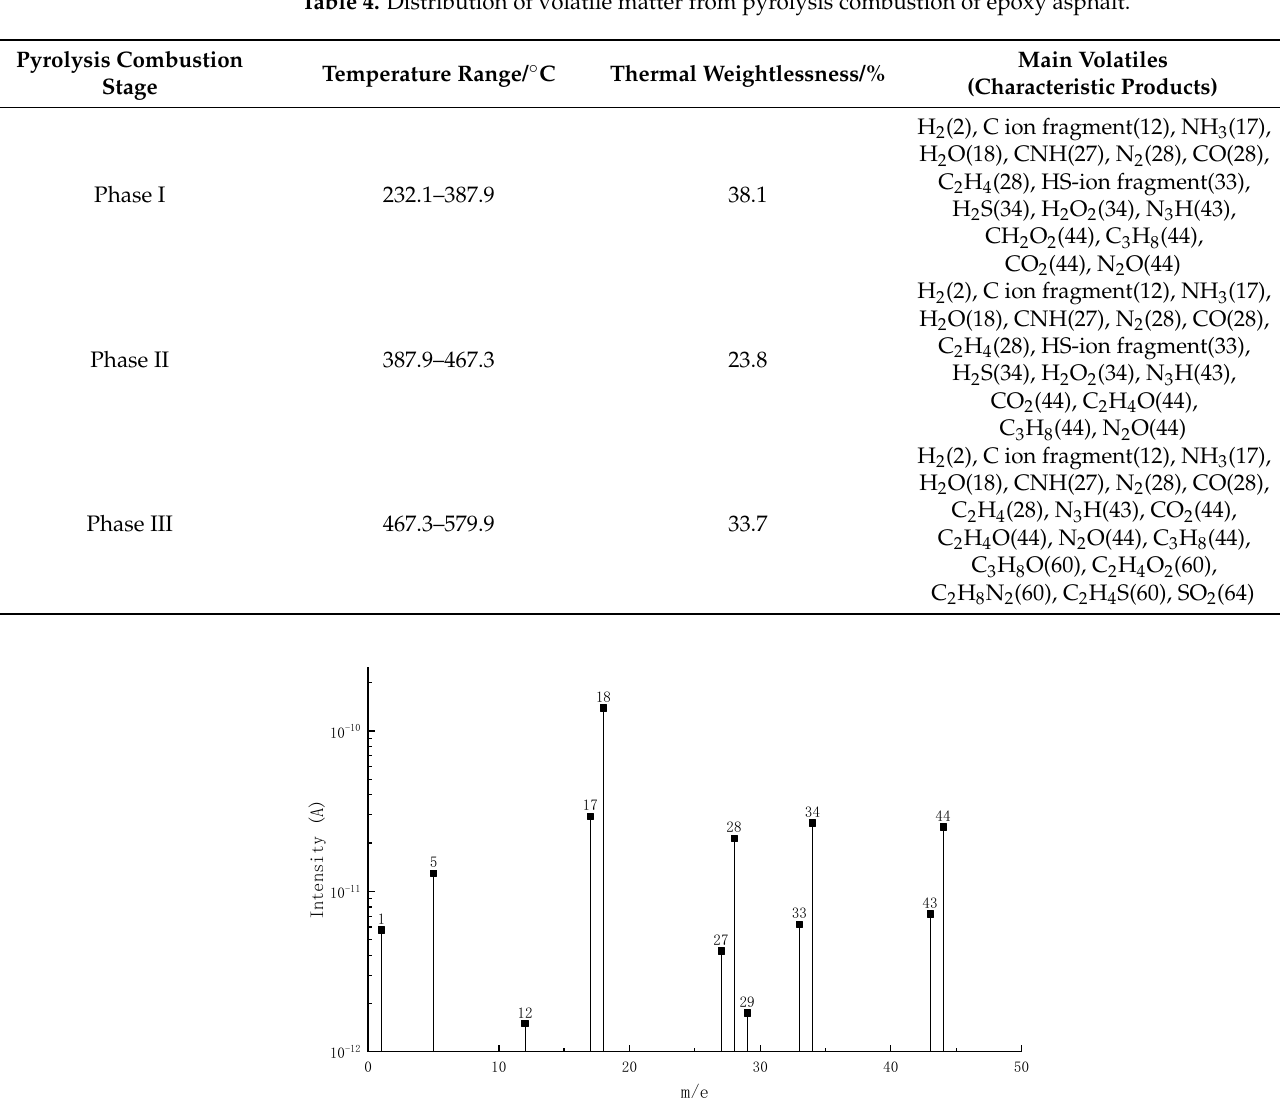
Figure 3. Mass spectrum of volatile matter from pyrolysis combustion of epoxy asphalt at characteristic temperature (342.8 °C).